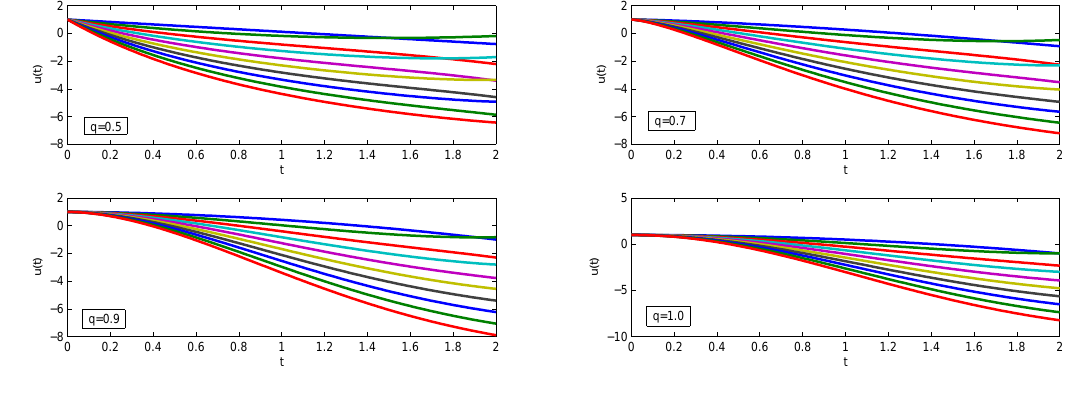
) q when q = 0 . 5 , 0 . 7 , 0 . 9 , 1 . 0 0